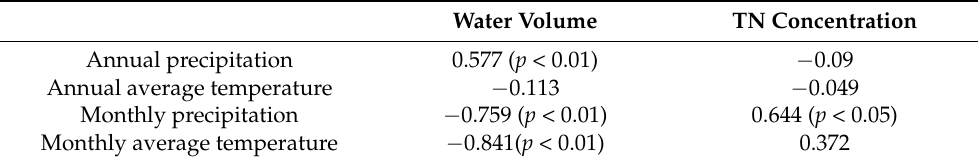
Table 3. Correlation coefficients of climatic factors, water volume, and pollutant concentration of Erhai Lake. Water Volume TN Concentration Annual precipitation 0.577 ( p < 0.01) − 0.09 Annual average temperature − 0.113 − 0.049 Monthly precipitation